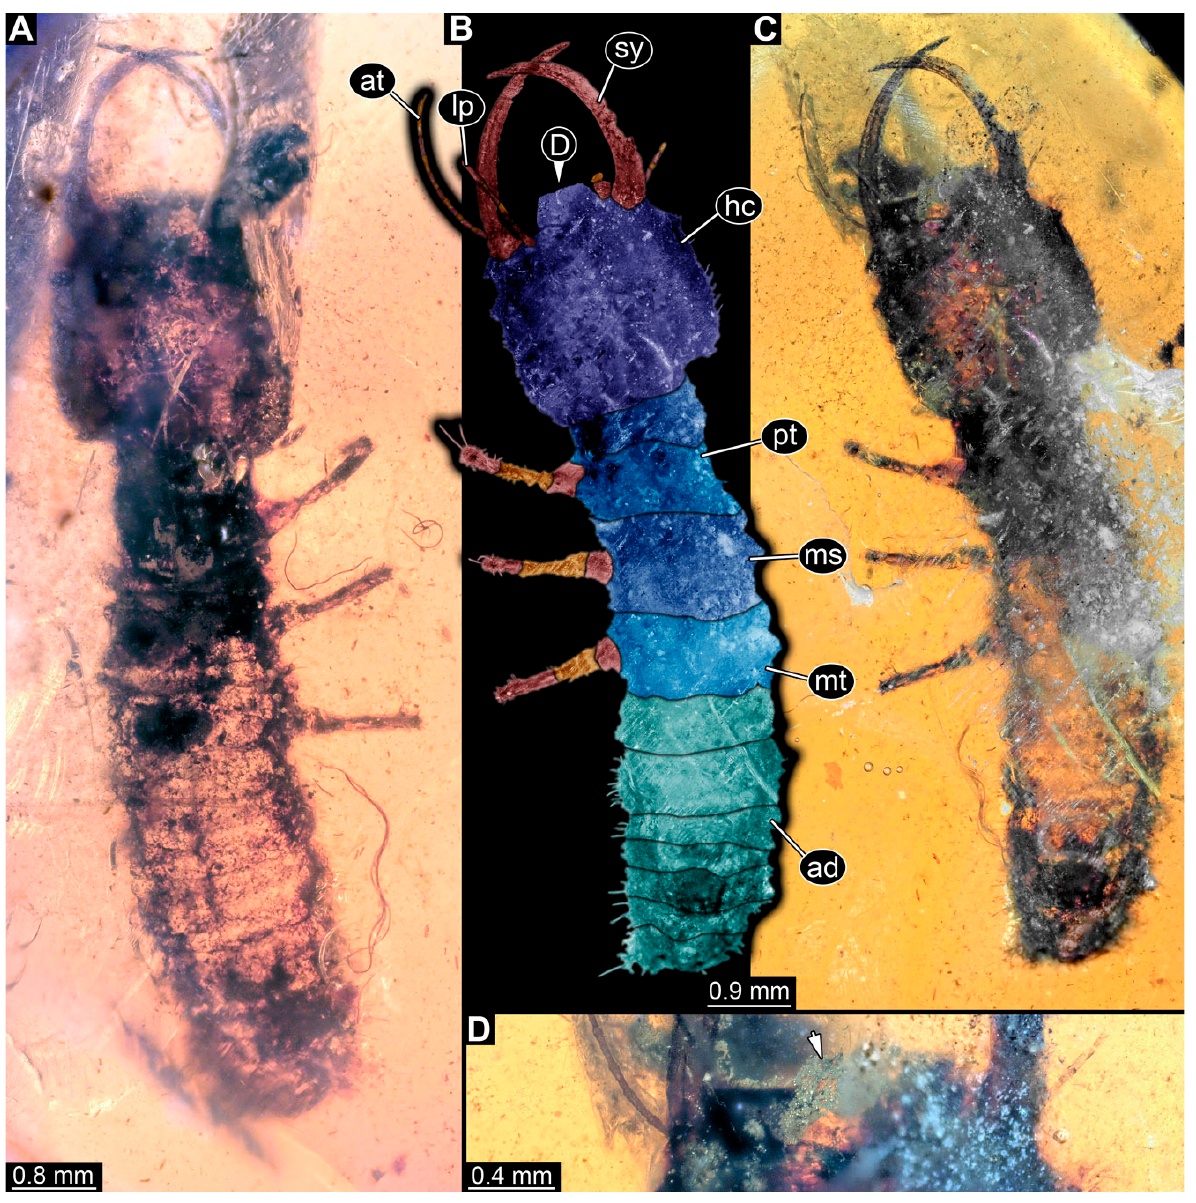
Figure 10. Specimen 68 (PED 0662); Myanmar amber. ( A ) Dorsal view. ( B ) Ventral view,